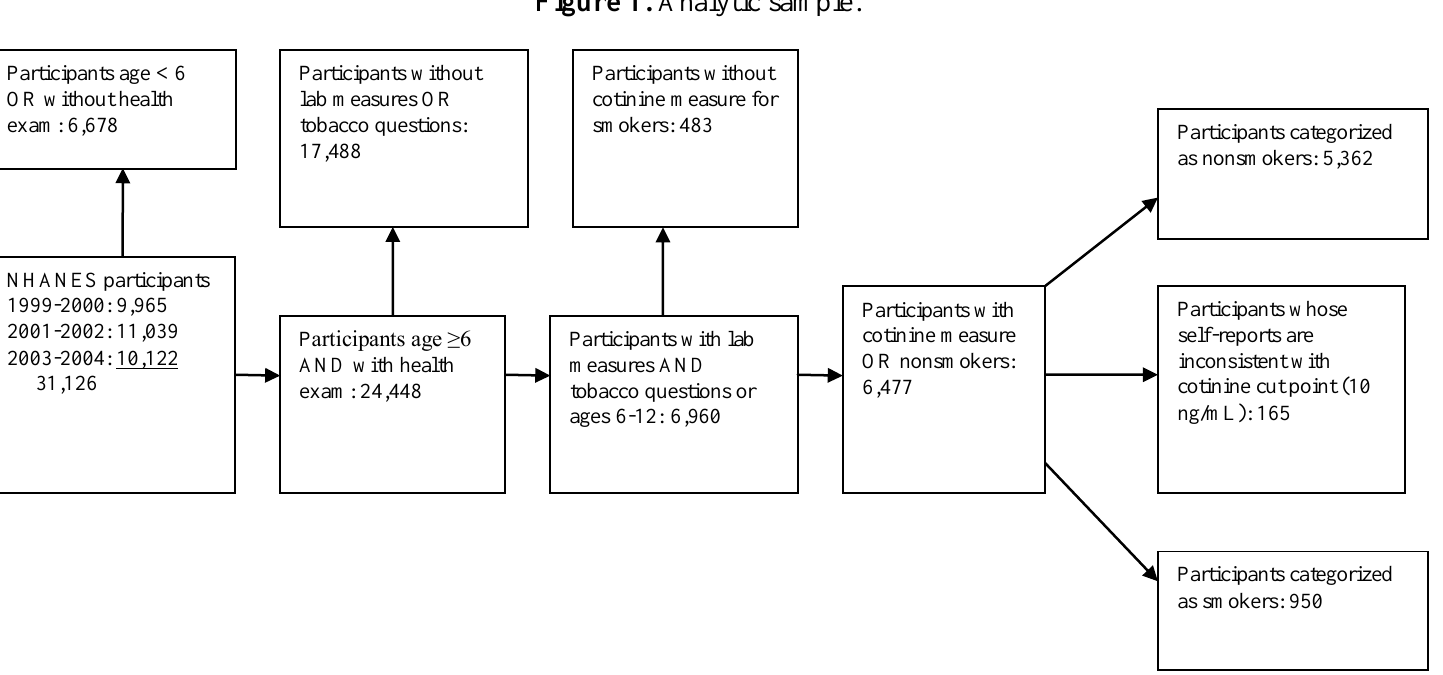
Figure 1. Analytic